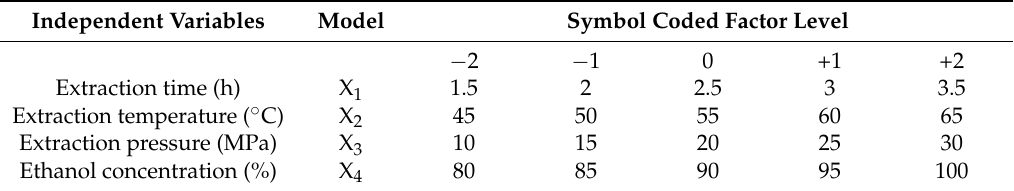
Table 4. Variables and experimental design levels for response